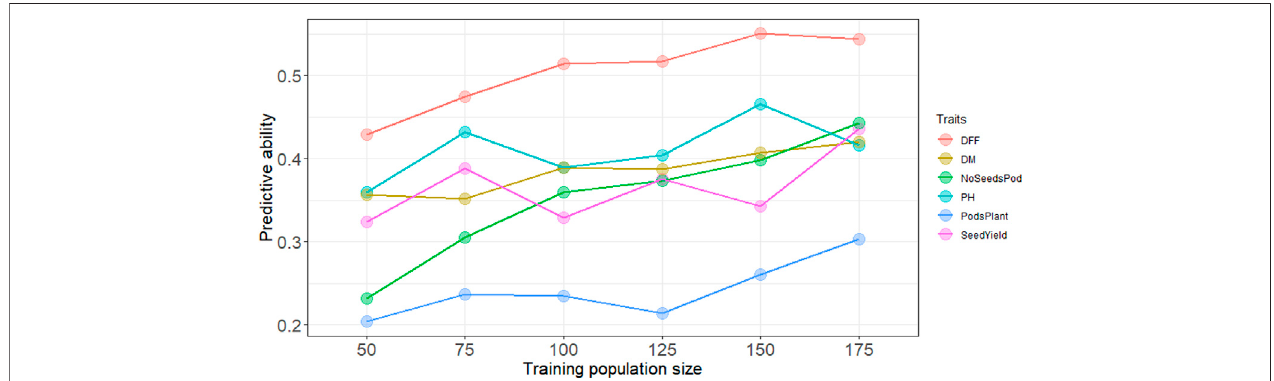
FIGURE1| PredictiveabilitywithincreasingtrainingpopulationsizeusingtheRR-BLUP model, DFFisdays to fi rst fl owering,DM,isdaystophysiologicalmaturity, NoSeedsPod is number of seeds per pod, PH is plant height in cm, PodsPlant is the number of pods per plant, SeedYield is seed yield in kg ha − 1 .